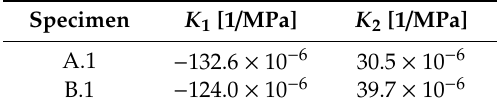
Figure 12. Change rates of the TOF with respect to the applied stress in specimen SB.1 for measurements of ( a ) K 1 and ( b ) K 2 . Table 4. Values of the acoustoelastic coefficients for specimens SA.1 and SB.1.